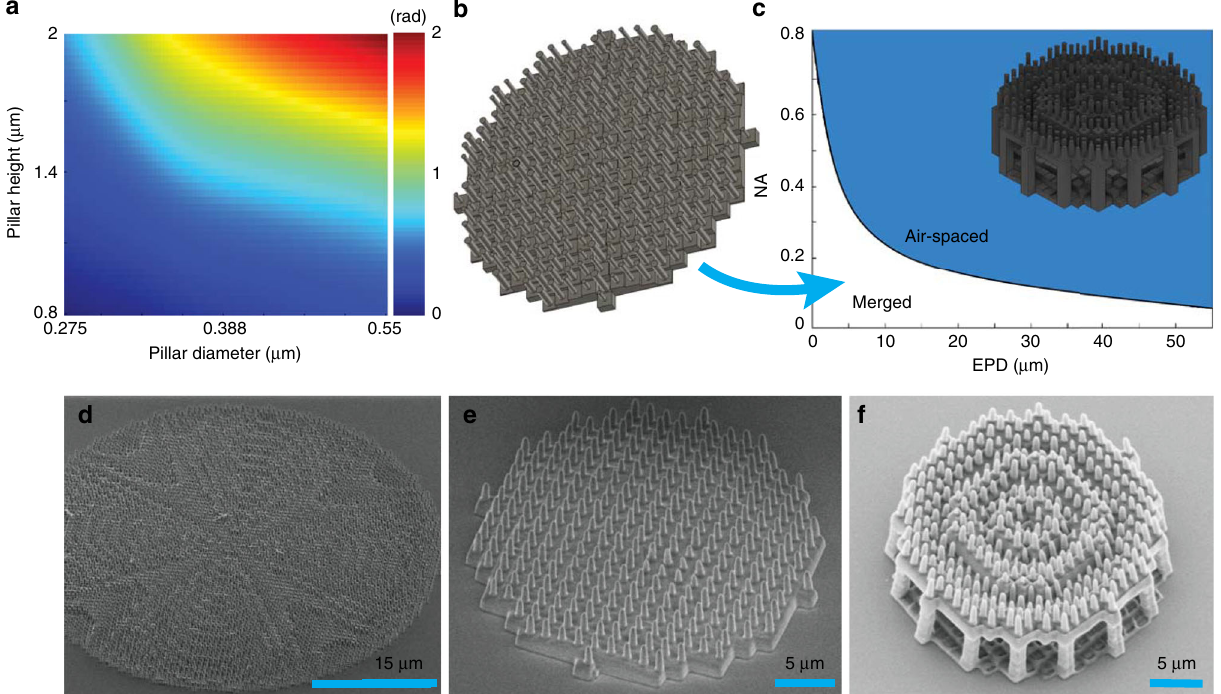
¼ 1 μ m . Variables min